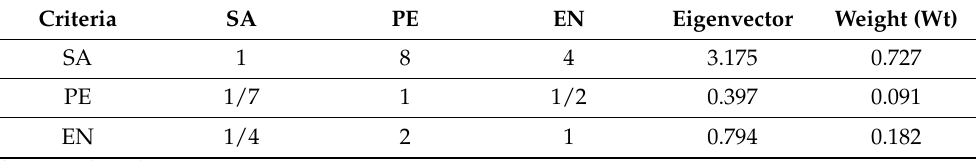
Table A1. Criteria comparison matrix.